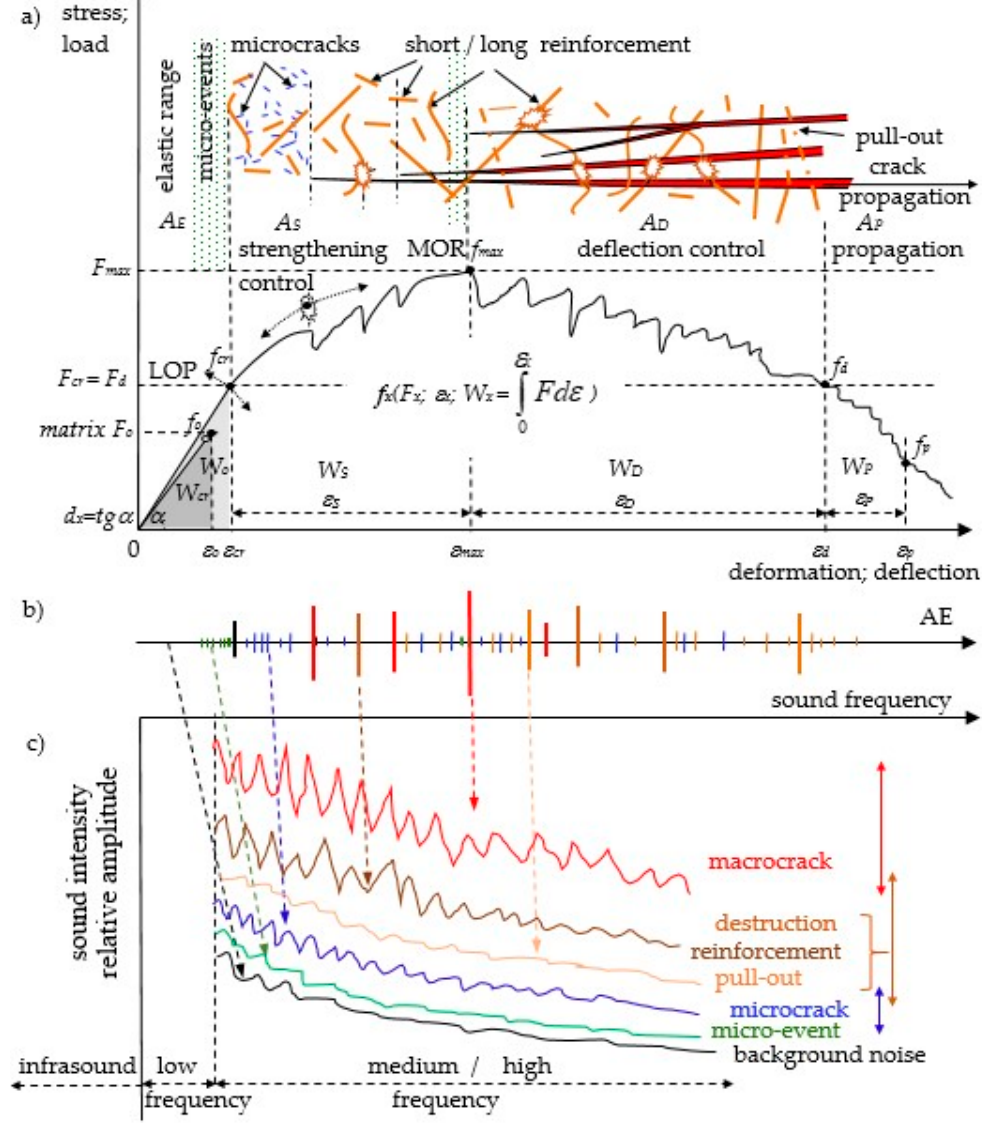
Figure 2. The quasi-brittle composite: ( a ) load–deflection curve; ( b ) AE—acoustic emission effects; ( c ) 2D acoustic spectrum (amplitude depending on sound intensity and frequency).